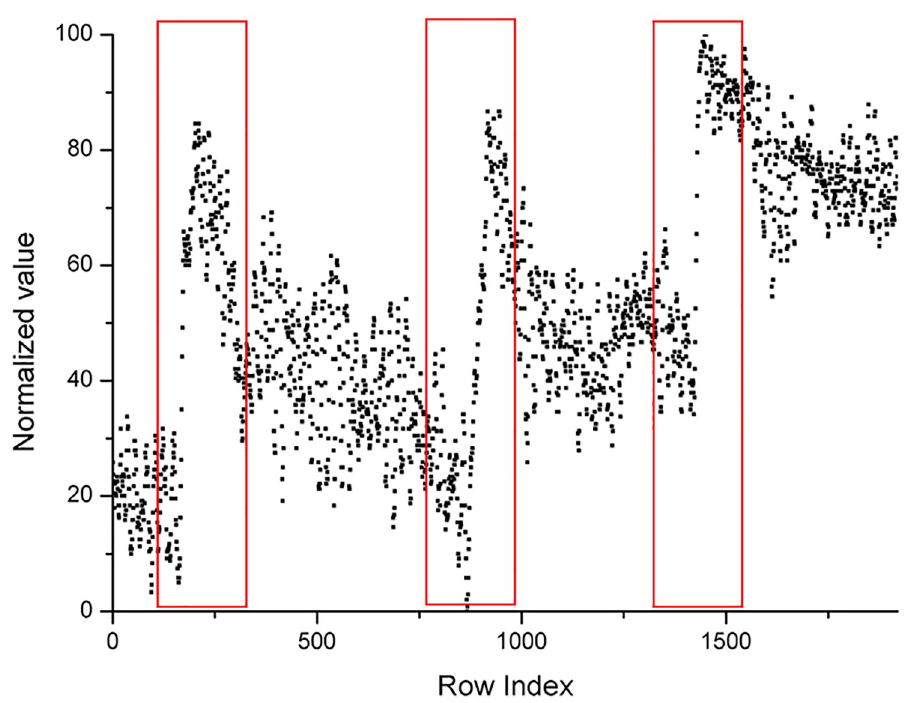
Fig 10. Scatter plot of the number of black pixels of Fig 8B after normalization.